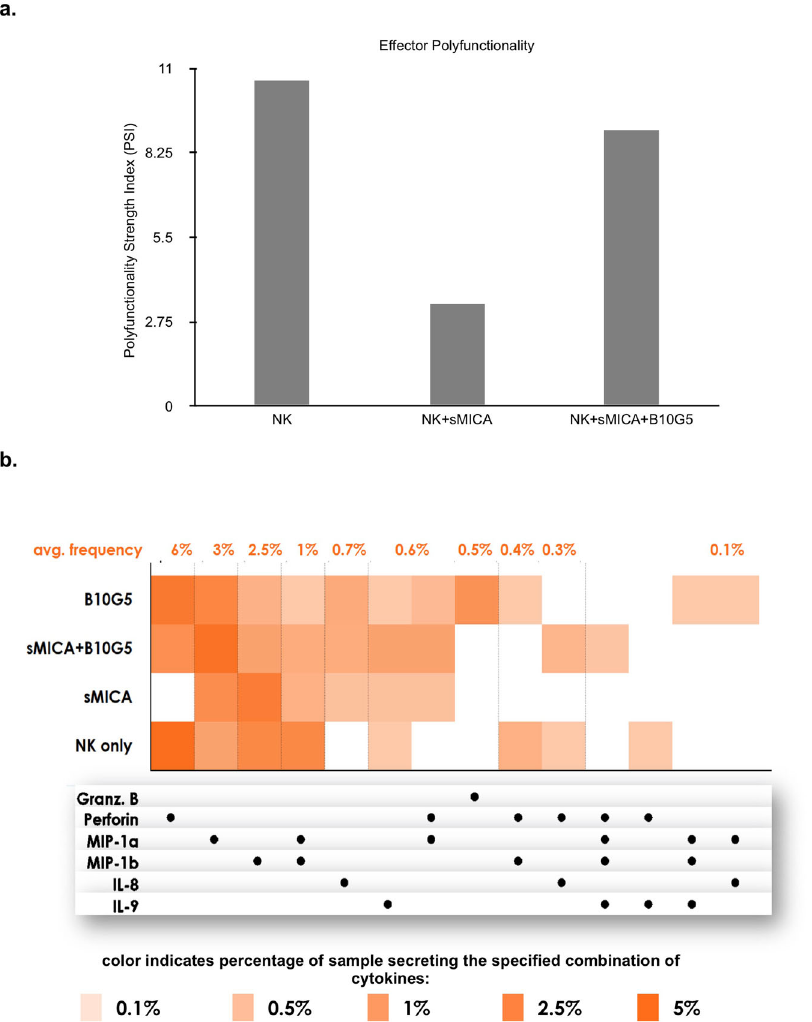
Fig. 6 sMIC abrogates the effector polyfunctionality of NK cells and polarizes NK cells to possess a pro-in fl ammatory phenotype. Primary human NK cells were cultured with recombinant soluble 100ng/ml of sMICA for 24h in the absence and presence of the sMIC-clearing mAb B10G5. In total, 30 µ L of cell suspension was loaded onto an IsoCode chip with a 32-plex antibody array for the measurement of secreted proteins. Polyfunctional Strength Index (PSI) was calculated as the percentage of polyfunctional cells in the sample, multiplied by the intensities of the secreted cytokines. a Bar graph representing the effector polyfunctionality strength index (PSI) of NK cells. b Single-cell functional heatmap illustrating differences in the single-cell secretion frequencies of various individual cytokines or combinations of cytokines. Each sample or condition is a row of the heatmap, while each column corresponds to the secretion of a speci fi c cytokine or a combination of cytokines. The dot(s) in each column indicate which cytokine(s) are represented by that column. Secretion frequency is denoted by the shade of orange color; the darker the orange color, the more frequently the corresponding cytokine(s) were secreted by a speci fi c sample or condition, as a percentage of pro fi led single